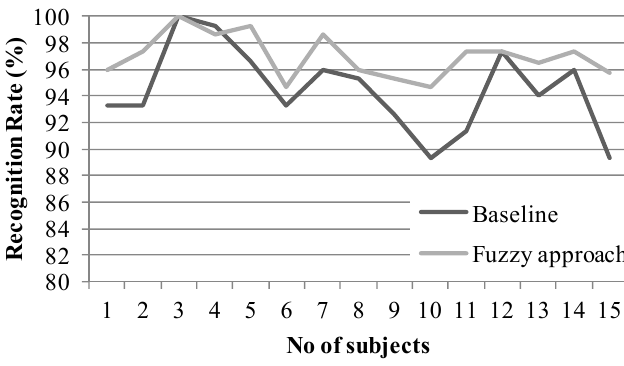
Figure 7. Experimental results for different subjects.